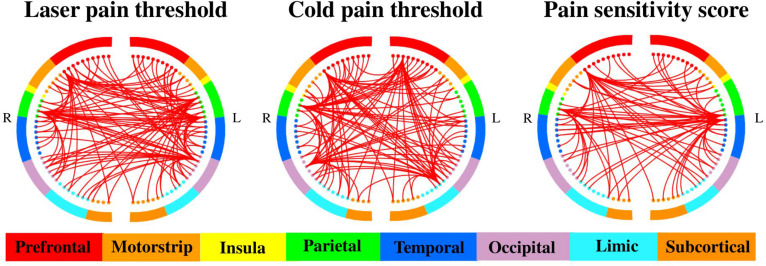
Selected MC features for the prediction of different measures of pain sensitivity. There were 460, 508, and 485 MC features selected for the prediction of laser pain thresholds, cold pain thresholds, and pain sensitivity scores, respectively. The two half circles represent two brain hemispheres, and the red lines represent the MC between two corresponding regions.